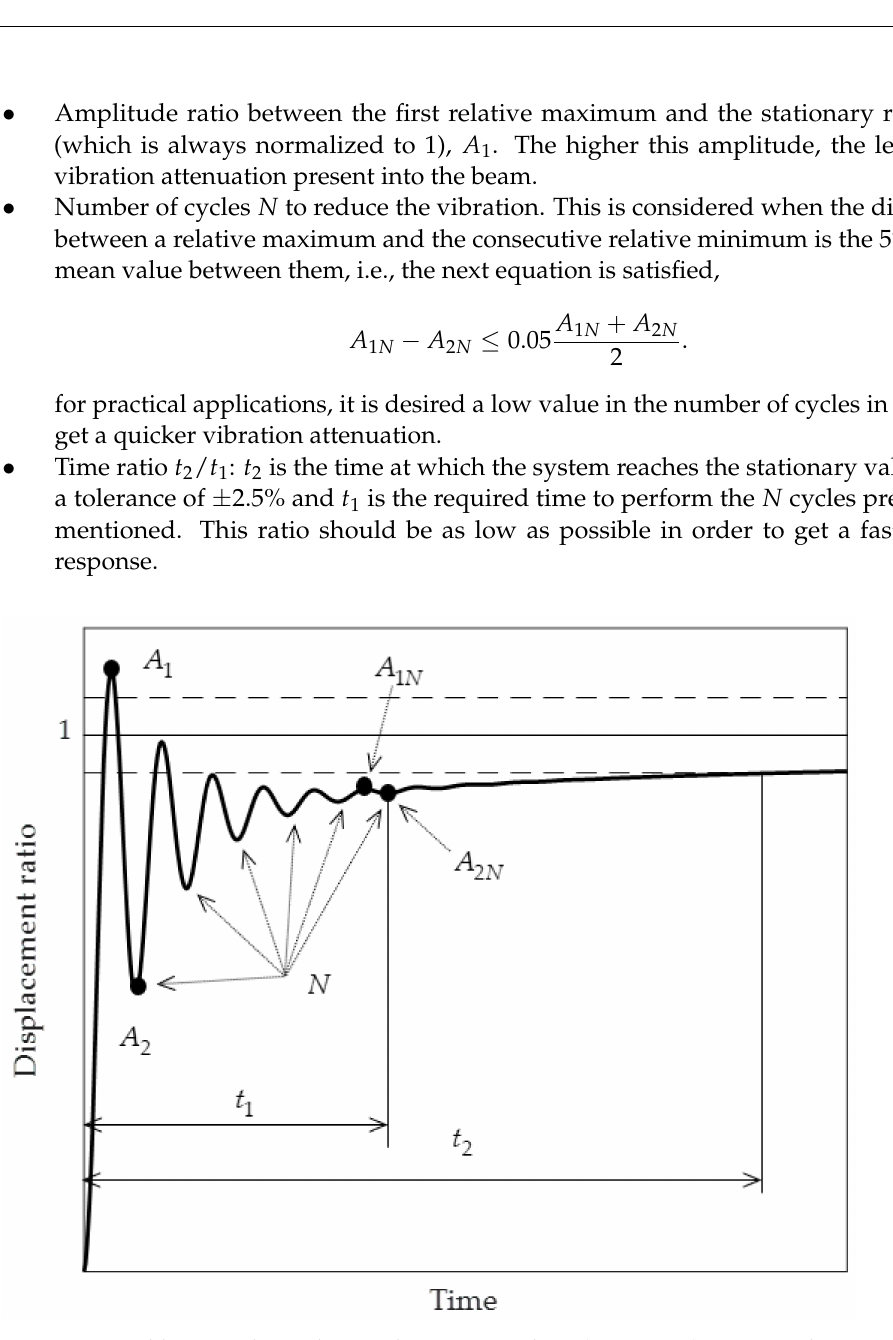
Figure 2. Variables to analyze. The two discontinuous lines ( ) represent the 2.5% interval of the stationary response, which is always 1 according to the definition of the displacement ratio A .